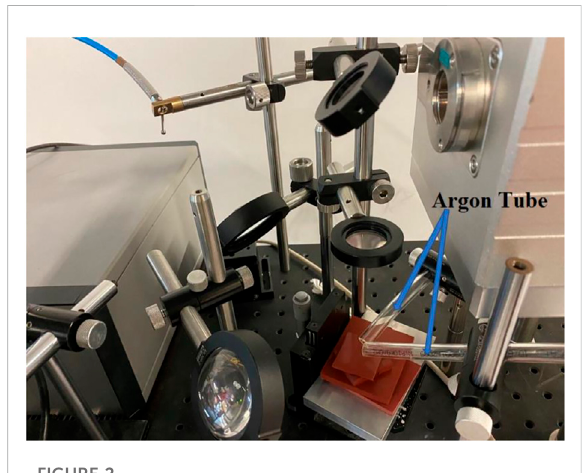
FIGURE 2 Argon tube purging sample surface device